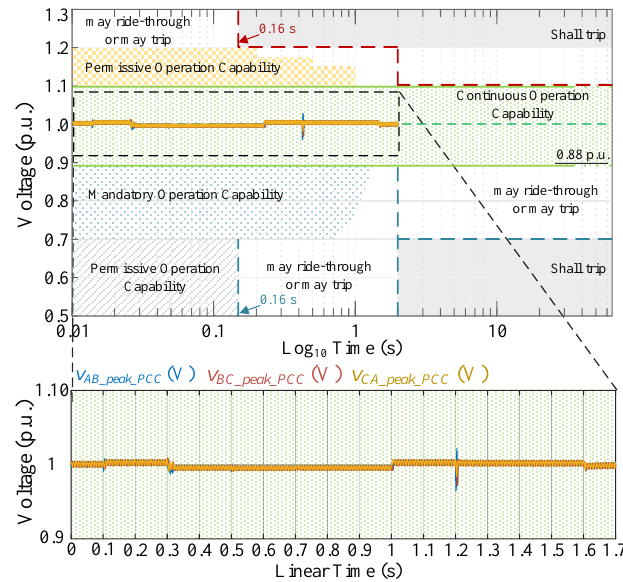
Figure 15. System response in the voltage amplitude measured at the